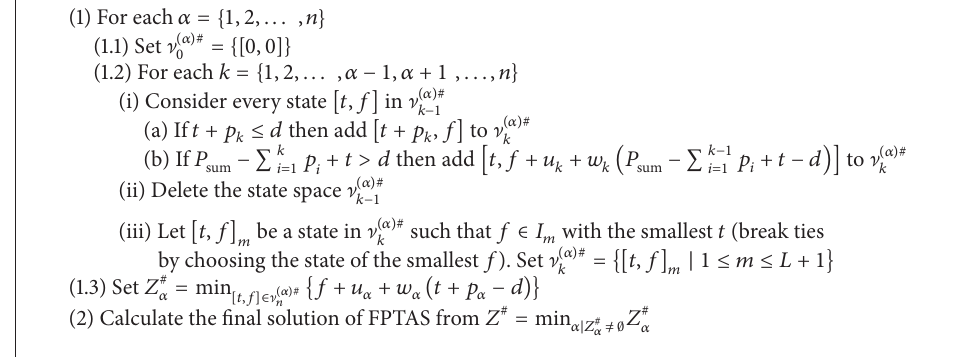
Algorithm 2: FPTAS algorithm.